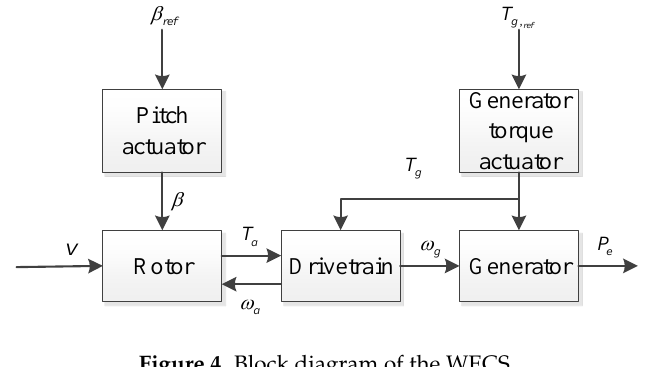
Figure 4. Block diagram of the WECS. Table 1. Model parameters for 5 MW wind turbine